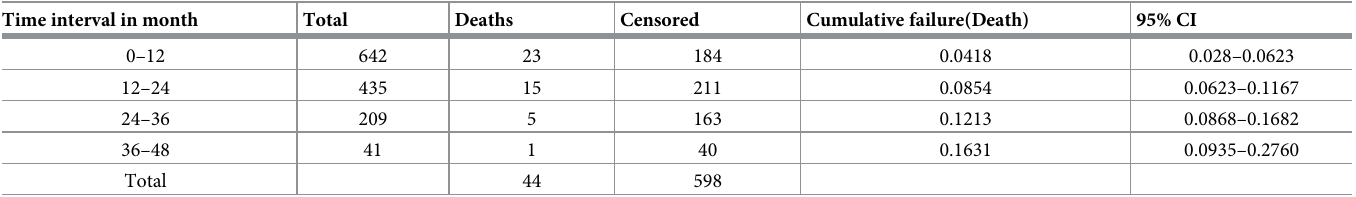
Table 4. Actuarial table for death among PLWHIV on second-line therapy, Dessie comprehensive specialized Hospital, northeast Ethiopia, October 2016—Novem- ber 2019. (n = 642). Time interval in